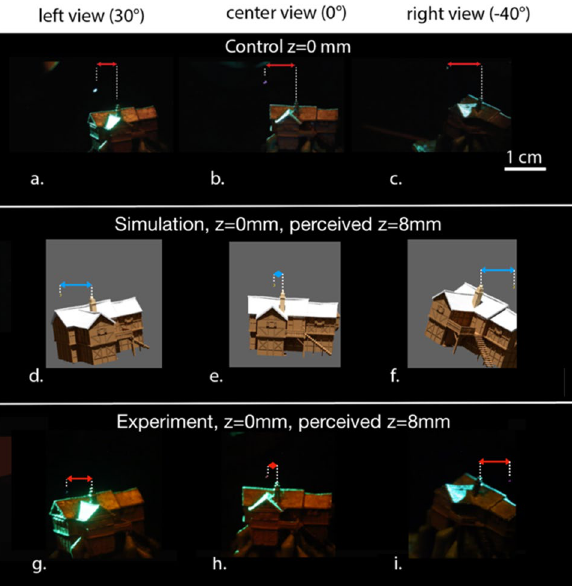
Figure 3. Experiment results. ( a – c ) Parallax for particle at z = 0 (in front of the house). ( d – f ) Simulation result, parallax for particle at z = 0, with perspective projection. ( g – i ) Experiment result, parallax for particle at z = 0, with perspective projection. The particle is in front of the house, but the parallax is consistent with a particle at z = 8 mm (behind the house). For full video, see “Supplemental Document” and Visualization